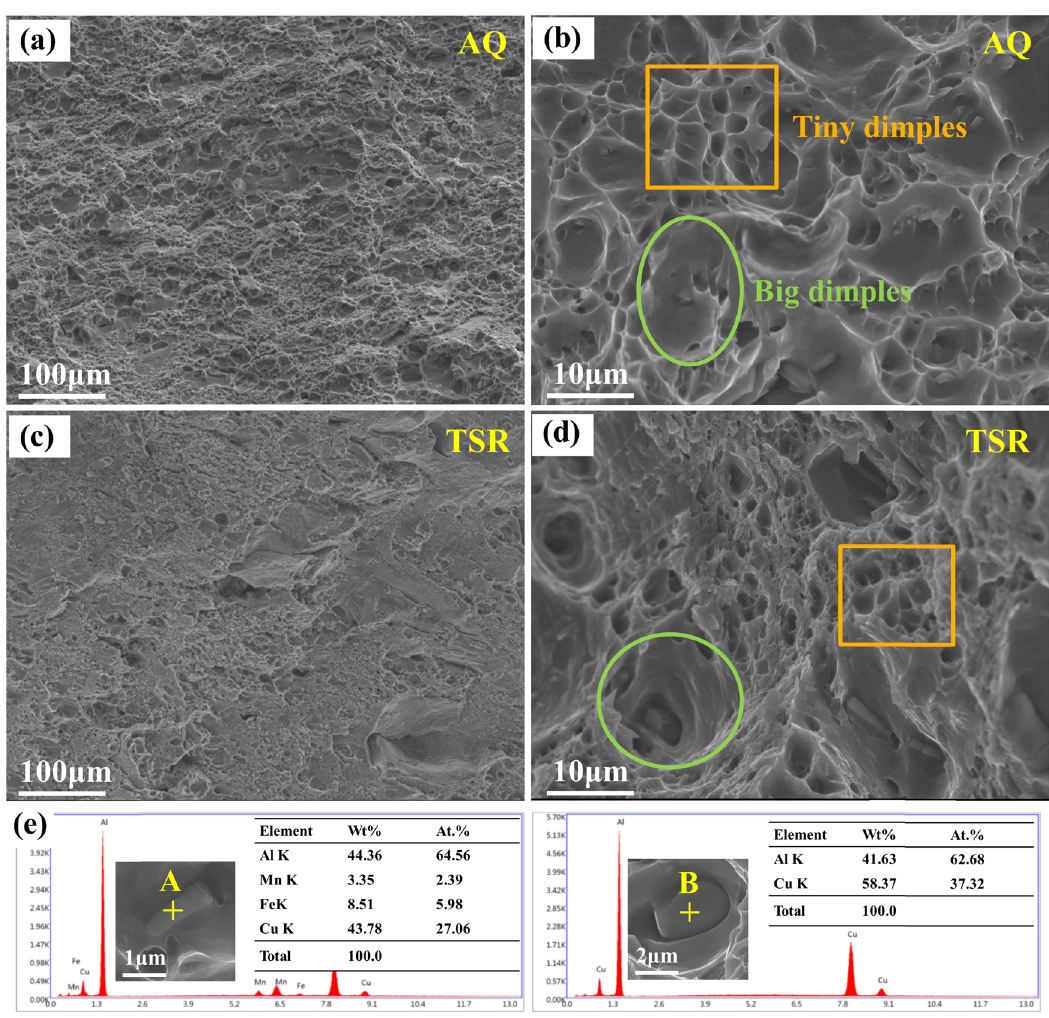
Figure 6: SEM images of tension - fracture surfaces: ( a and b ) AQ piece, ( c and d ) TSR piece, and ( e ) EDS analysis of